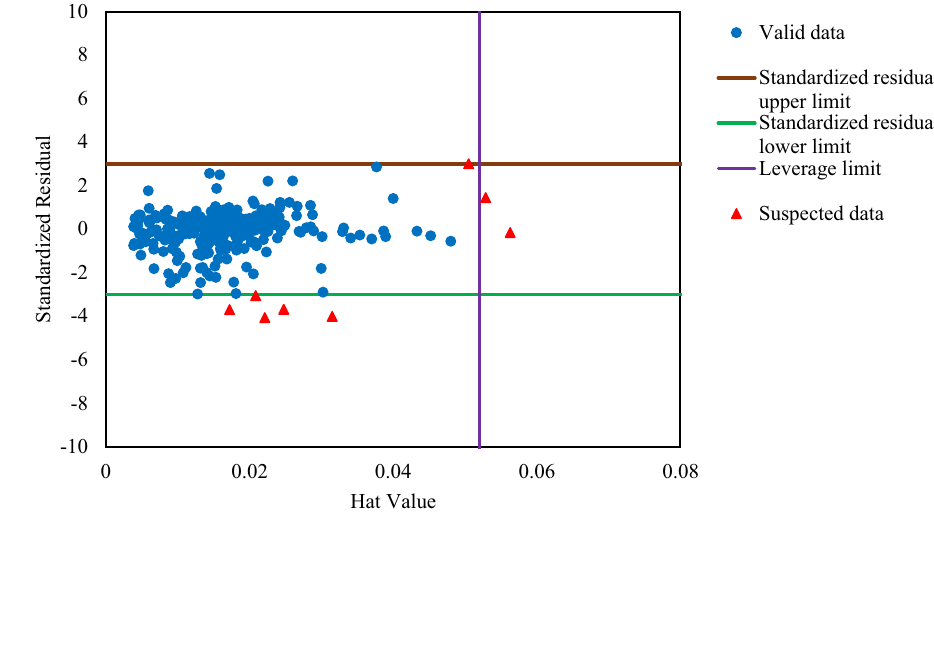
Fig. 8 The changes of the predicted VES viscosity with different input parameters of VES concentration (C perature